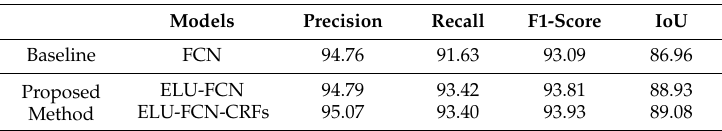
Table 3. Results on the testing data of Massachusetts aerial images for the variations of our proposed techniques in terms of precision (%), recall (%), F1-score (%), and IoU